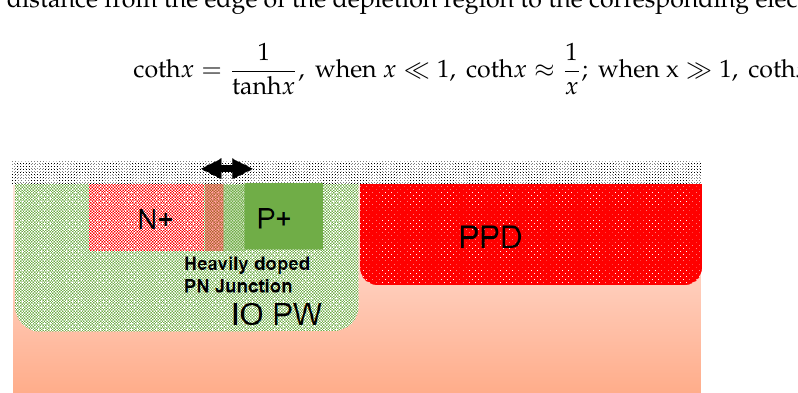
Figure 6. The cross-section schematic of the yellow arrow in Figure 5.